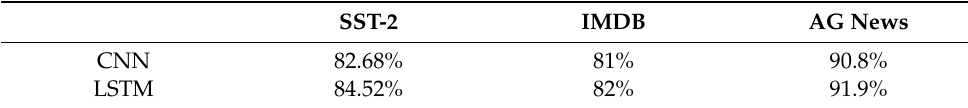
Table 6. Accuracy of Target Models.